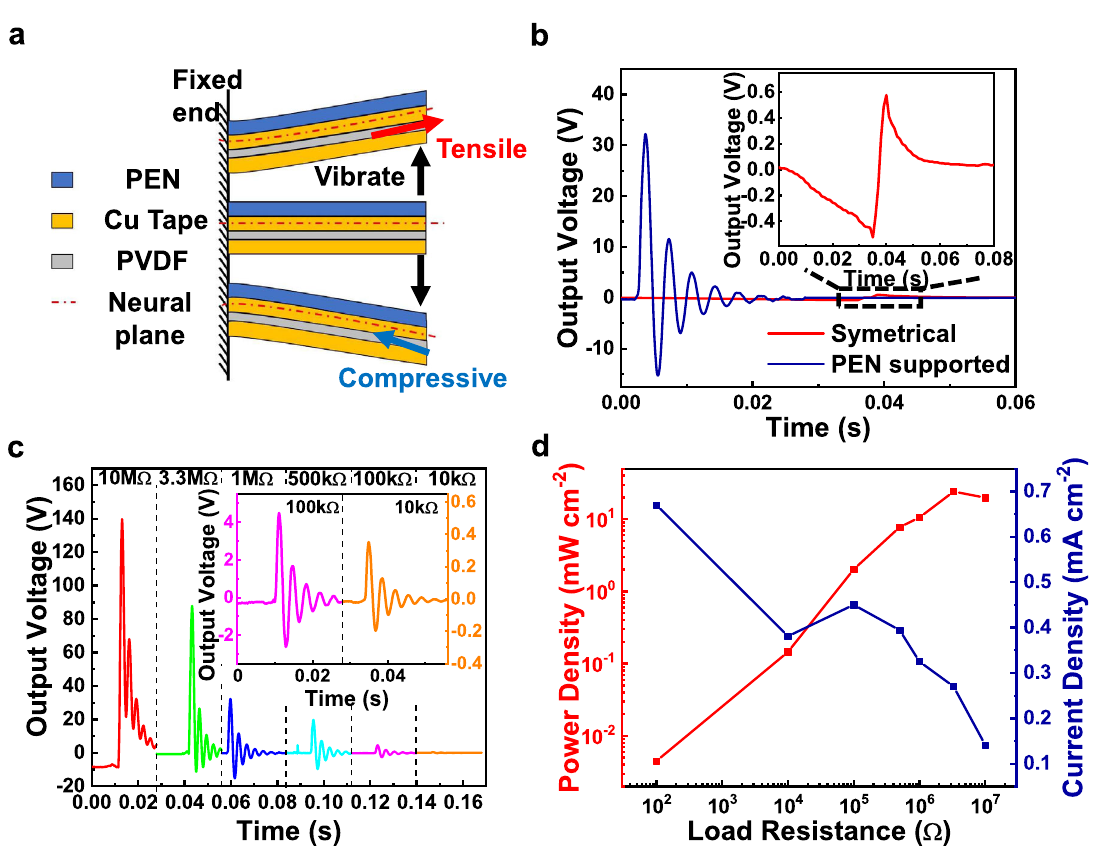
Fig. 2 | Performance optimization and characterization of PVDF piezoelectric generator. a Schematicdiagram of the neutralplaneofa multilayersystemand its effect on how internal stress react to free vibration behavior. b Comparison of piezoelectric output with and without (symmetrical structure) PEN support layer.